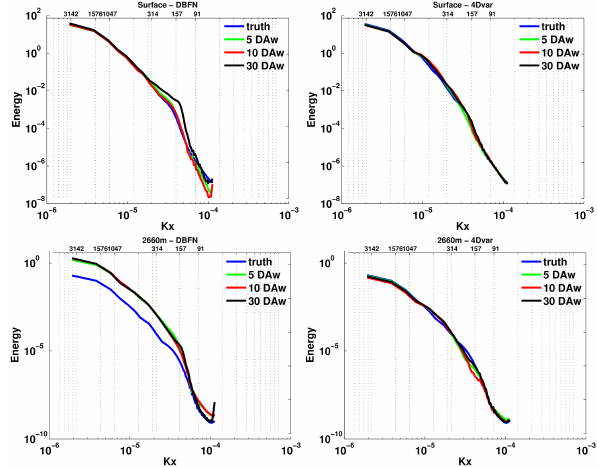
Figure 12. Kinetic energy mean power spectra calculated using the first layer (top) and a layer at 2660m (bottom) and using the 650 days of the assimilation experiments using the DBFN (left) and the 4Dvar (right). Blue curves represent the “true” power spectra; green curves represent the power spectra calculated for the 5day DAw; red curves represent the power spectra calculated for the 10day DAw; and black curves represent the power spectra calculated for the 30day DAw. In the bottom abscissa the tick labels stand for lon- gitudinal wave number (radm − 1 ) while in the top abscissa the tick labels stand for the corresponding wavelengths in km units.